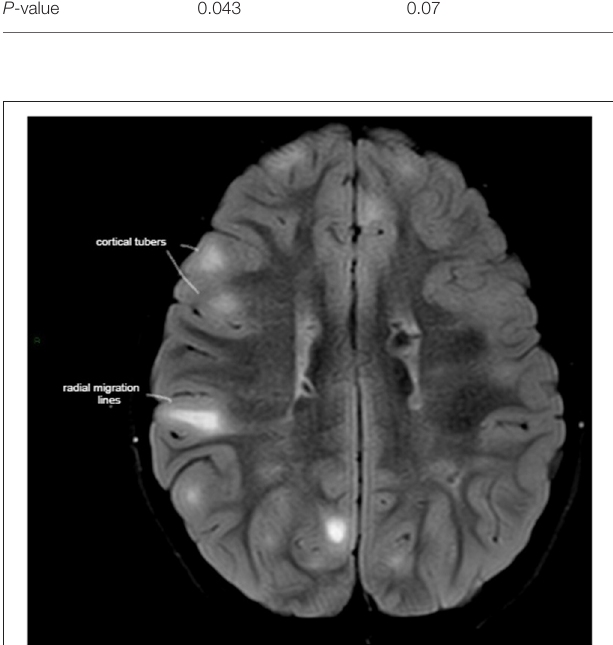
FIGURE 1 | Axial T2-weighted fluid-attenuated inversion recovery (T2-FLAIR) MRI demonstrating high tuber load and radial migration (RM) white lines in a 7-year-old boy with tuber sclerosis complex, normal intelligence, peer relationship problems, and hyperactive/inattention, which correlated negatively with RM lines in the parietal